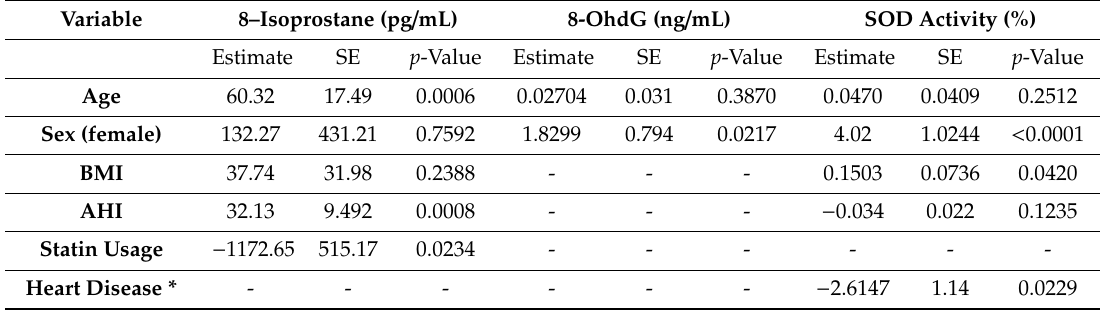
Table 3. Multiple Linear Regression